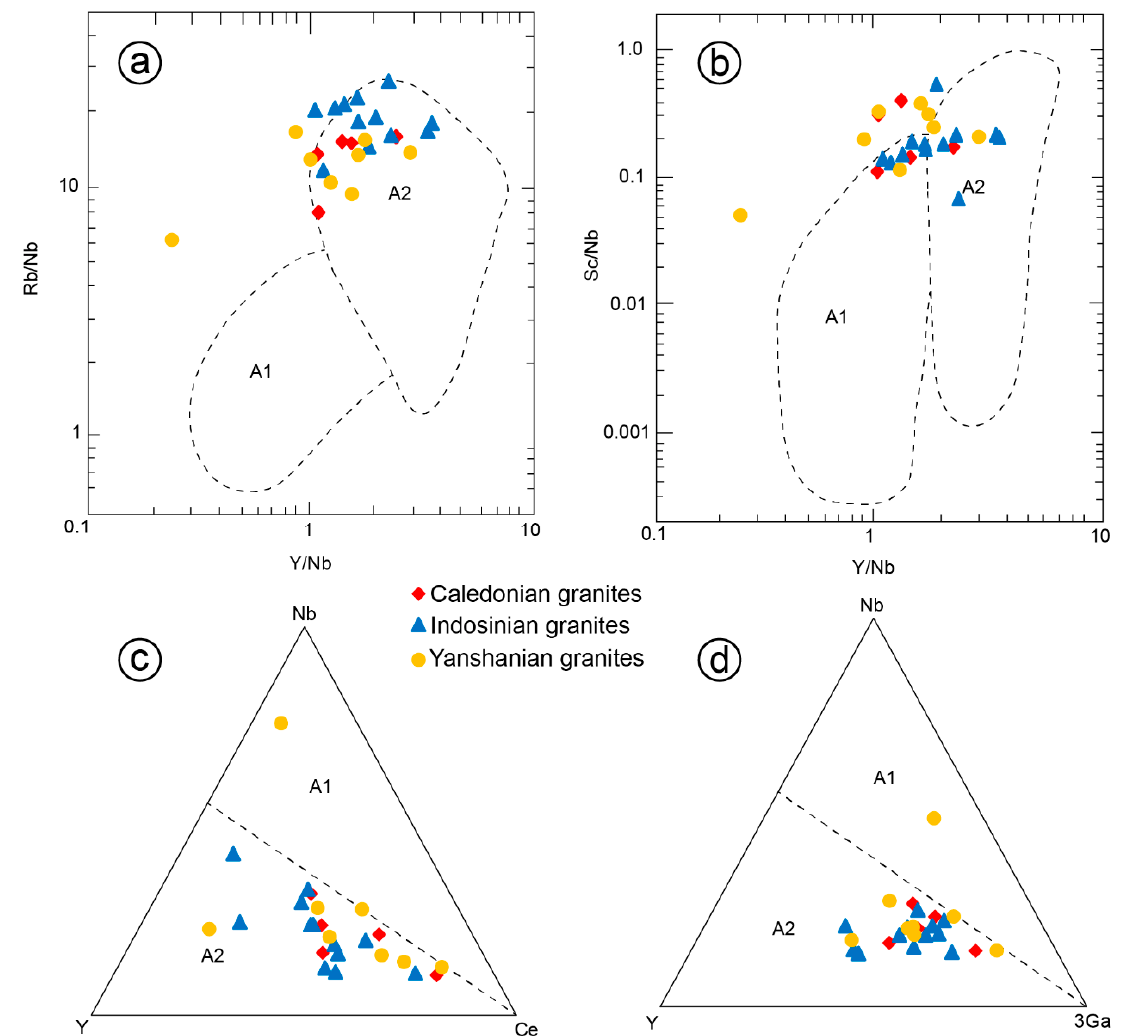
Figure 18. ( a ) Rb/Nb versus Y/Nb, ( b ) Sc/Nb versus Y/Nb plots for various A-type granites from the Taoxi dome. ( c , d ) are representative triangular plots for distinguishing between A1 and A2 granites in the Taoxi dome. Diagrams are from Eby (1992) [45].